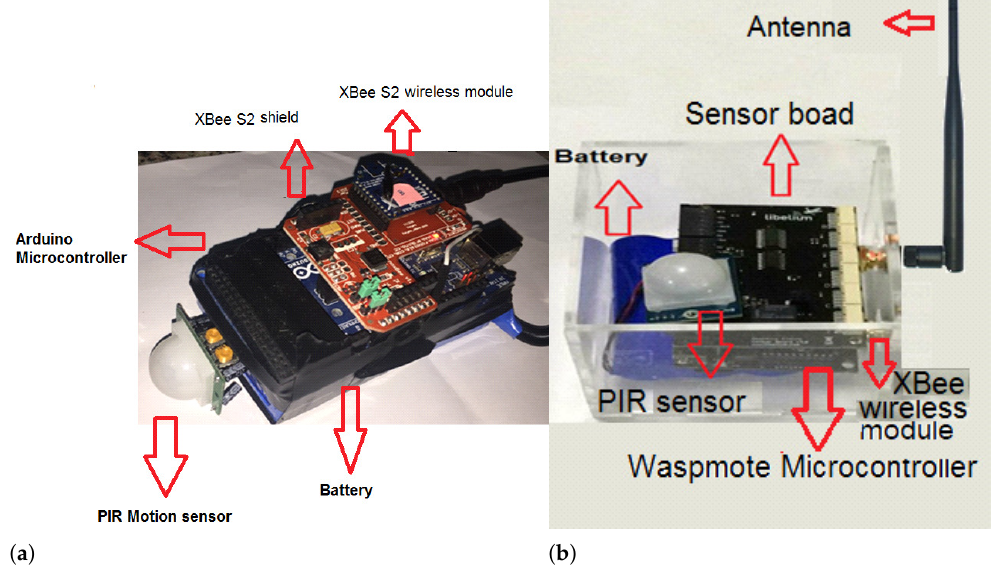
Figure 7. ( a ) the first and ( b ) the second implementations for the wireless sensor nodes using a PIR motion sensor as an